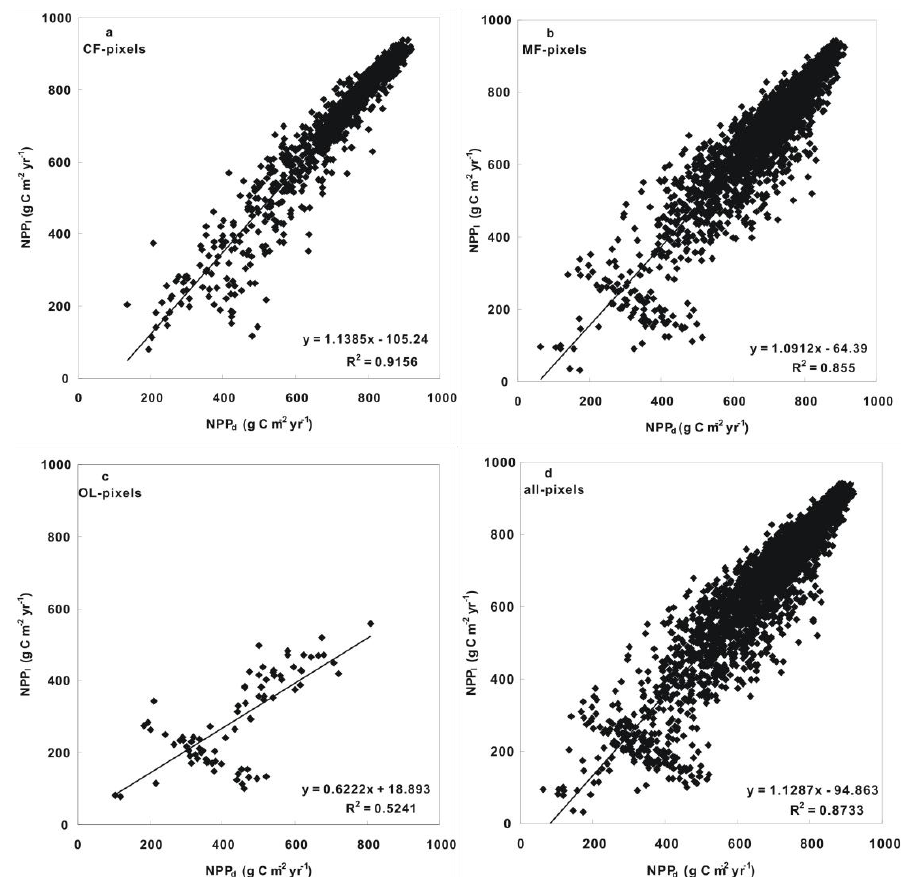
Fig. 9. Regression between distributed (NPP d ) and lumped (NPP l ) annual values after land cover (SSI LC ) correction: (a) pixels dominated by the coniferous forest (CF-pixels) at the 1km resolution; (b) pixels dominated by the mixed forest (MF-pixels) at the 1km resolution; (c) pixels dominated by open land (OL-pixels) at the 1km resolution; and (d) all pixels for all land cover types (all-pixels). Figure 9. Regression between distributed ( NPP d ) and lumped ( NPP l ) annual values 5 after land cover ( SSI LC ) correction: (a) pixels dominated by the coniferous forest 6 The algorithm to correct the effects of slope on NPP is (CF-pixels) at the 1 km resolution; (b) pixels dominated by the mixed forest 7 similar to that used in the LC correction, (MF-pixels) at the 1 km resolution; (c) pixels dominated by open land (OL-pixels) at 8 the 1 km resolution; and (d) all pixels for all land cover types (all-pixels). 9 10